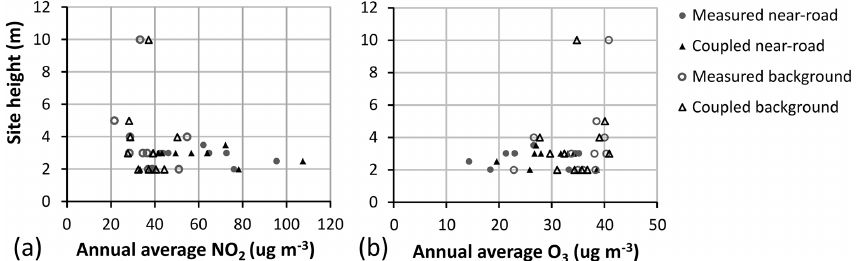
Figure A2. NO 2 (a) and O 3 (b) annual average concentrations from measurements and the coupled model, plotted against site height.